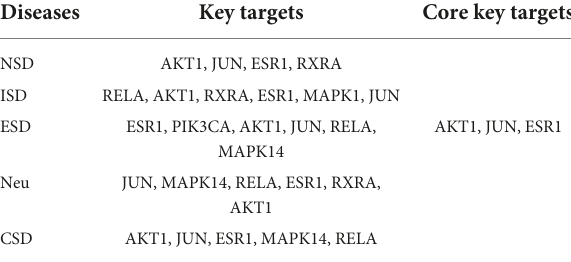
TABLE 2 The key targets for Tremella aurantialba on five